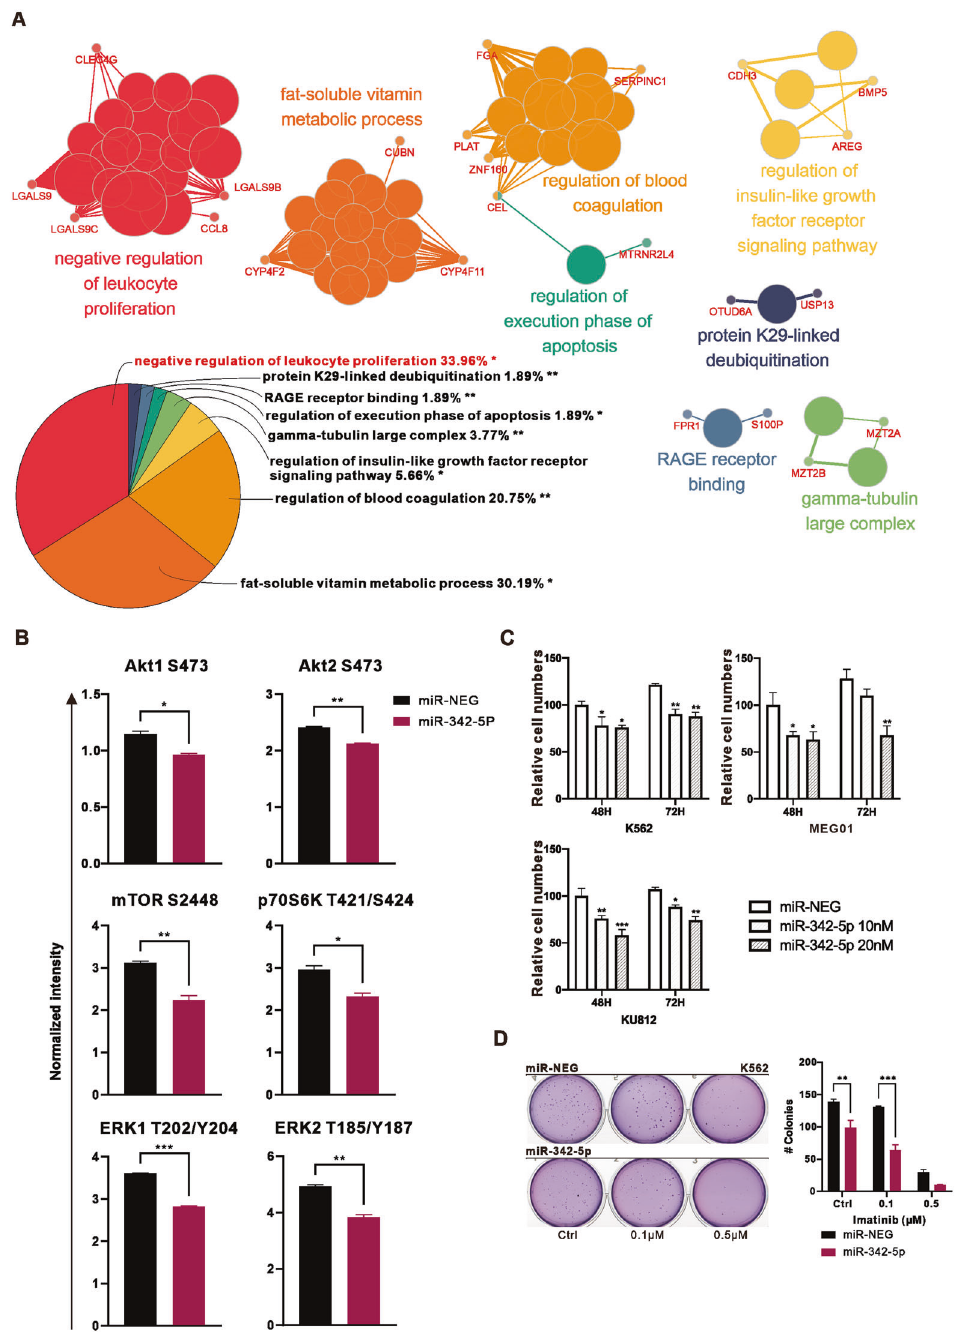
Fig. 4 miR-342-5p upregulated-genes are associated with negative regulation of leukocyte proliferation. A Presenting miR-342-5p upregulated-gene related ontology using Cytoscape ClueGO plugin. “ GO biological processing ” was utilized in the analysis. Node clusters represent enriched ontologies or pathways ( p < 0.05), and the genes associated with the nodes are shown around the cluster. Pie charts present the proportion of each ontology in the collection. B The box plots present the normalized intensity of various protein phosphorylation sites with miR-NEG or miR-342-5p expression in the K562 CML cell line using a Human phospho-MAPK array. C The effect of miR-NEG and miR-342-5p at 10 or 20 nM on the relative cell numbers at 48 h or 72 h was assessed using Trypan blue assay. D Soft agar assay to evaluate colony formation with 0.1 or 0.5 μ M imatinib treatment under miR-NEG or miR-342-5p expression (20 nM). The bar chart shows the difference in the number of colony formations. Each data represents mean ± SD from independent experiments performed in triplicate. The student ’ s t -test or One-way ANOVA approach was used to assess the signi fi cance. * P < 0.05; ** P < 0.01; *** P < experimentally beforehand (data not shown), and the animals inhibition of miR-NEG or miR-342-5p-expressing K562 cells with were sacri fi ced on day 15 to obtain the implanted MTAM. imatinib oral administration [12, 13]. Figure 6A describes the Interestingly, signi fi cant neovascularization around MTAM was details and procedures of the subcutaneous implantation MTAM found in the side receiving imatinib with miR-NEG, while no model. The maintenance expression of miR-342-5p was con fi rmed